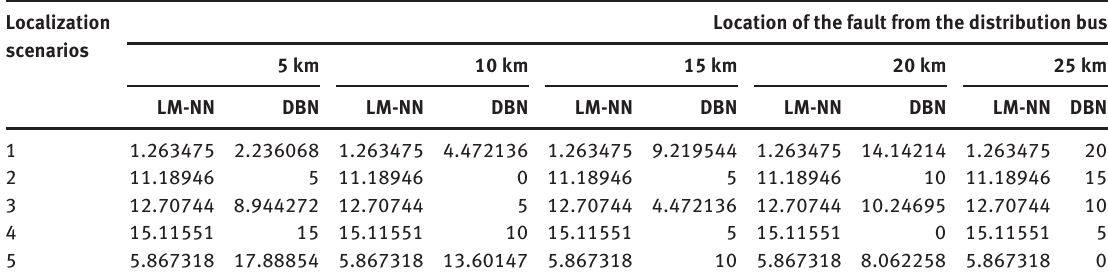
Table 5: RMSE Analysis on Fault Signal Recognition in Transmission Line with Different Lengths in Power Distribution